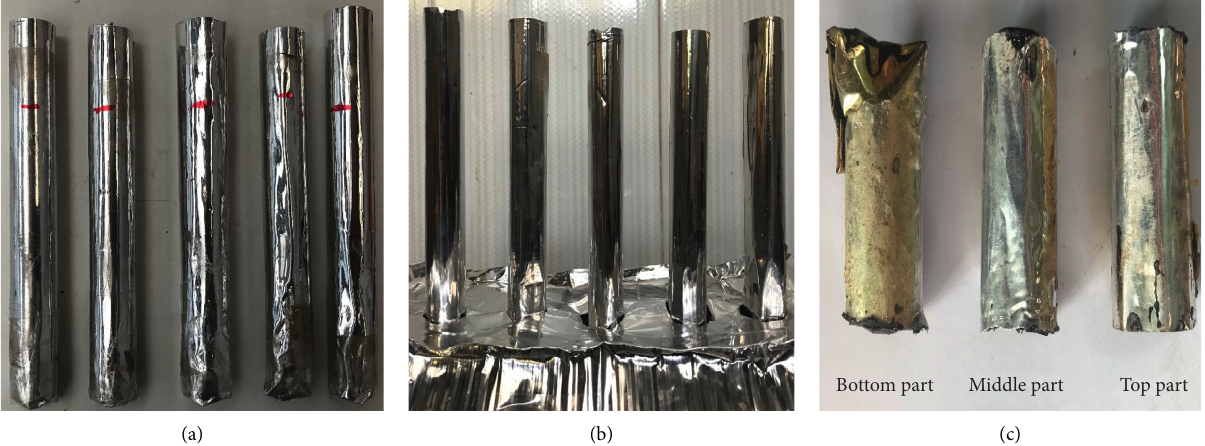
Figure 3: Storage stability test: (a) aluminum tubes, (b) prepared samples, and (c) three parts of the